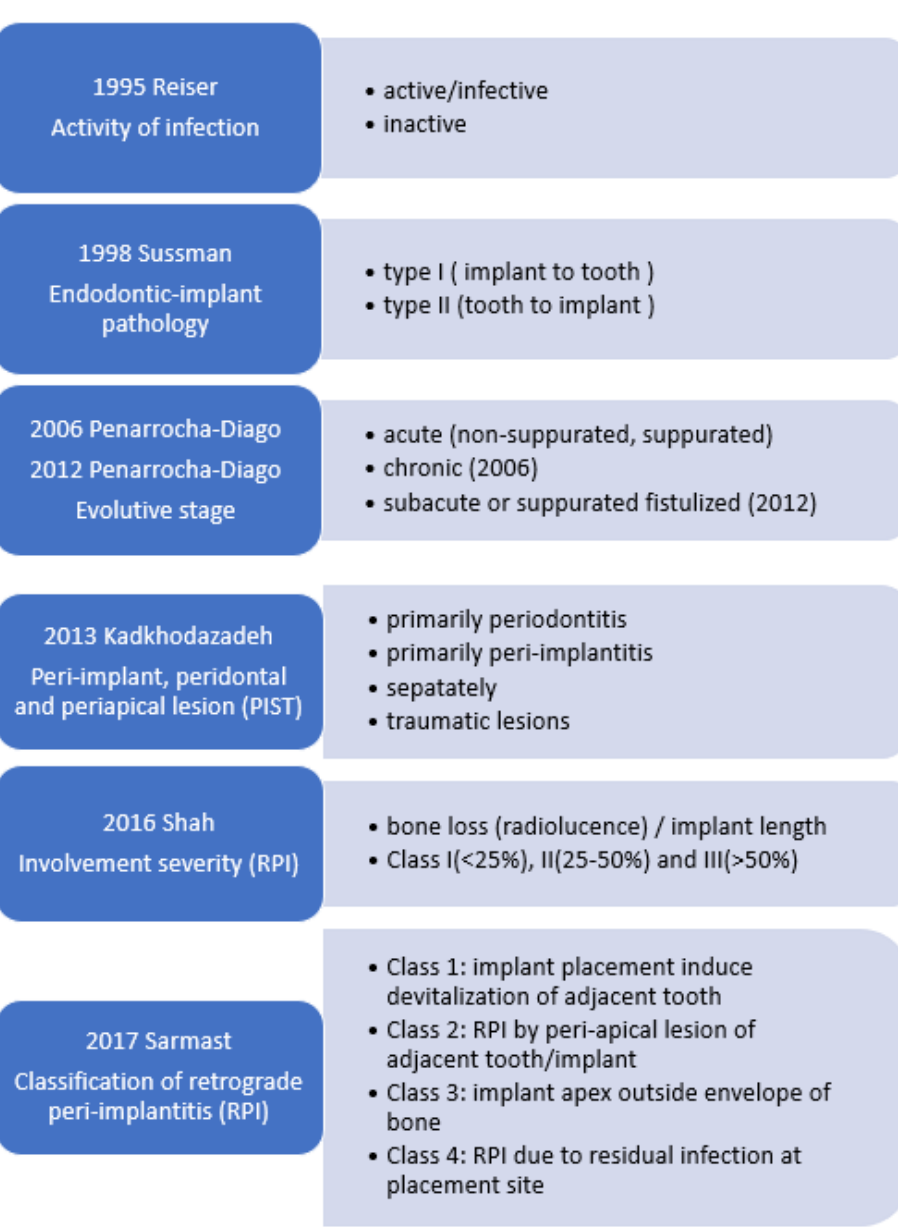
Figure 3. Classification systems of implant periapical lesion based on various parame- ters.